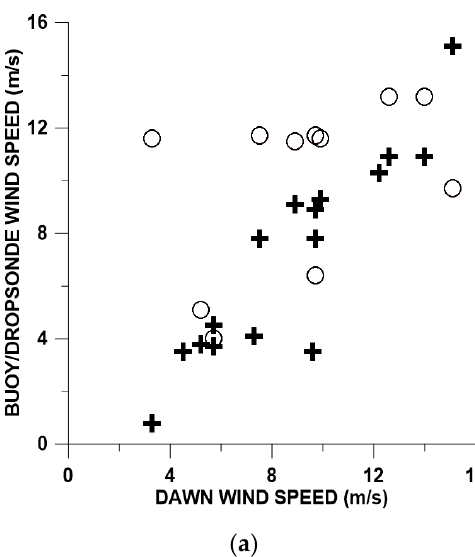
) comparisons for wind speed (cid:35)